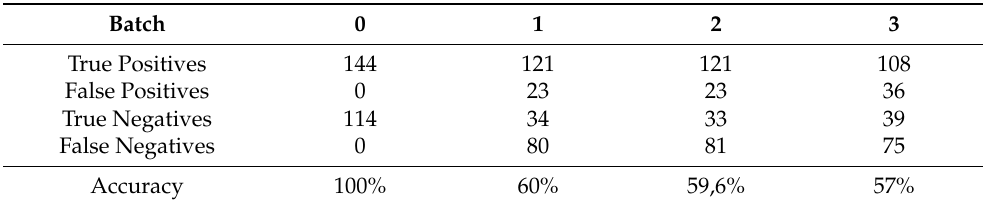
Table 3. Classifier’s accuracy without hyperparameters’ optimisation over training batches using ReLu activation